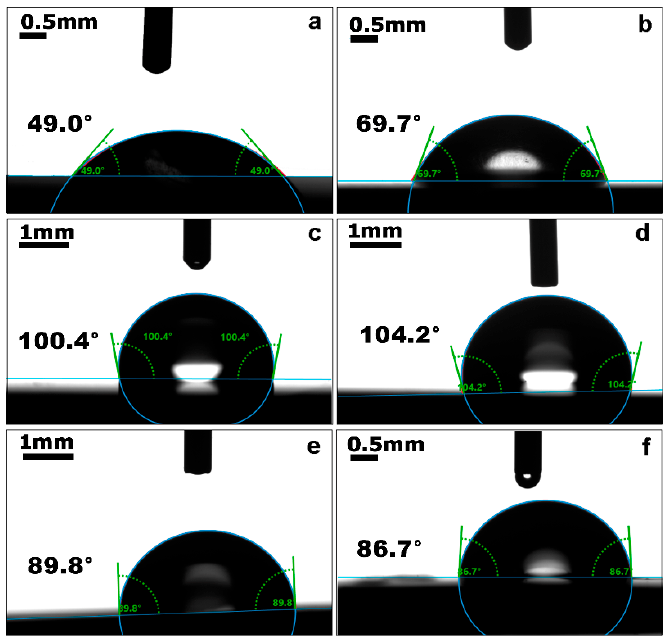
Figure 6. Contact angle of ( a ) AA2024, ( b ) AA2024 + TE, ( c ) AA2024 + PMMA, ( d ) AA2024 + TE + PMMA, ( e ) AA2024 + TE + PMMA-Ag 0.01 wt%, and ( f ) AA2024 + TE + PMMA-Ag 1